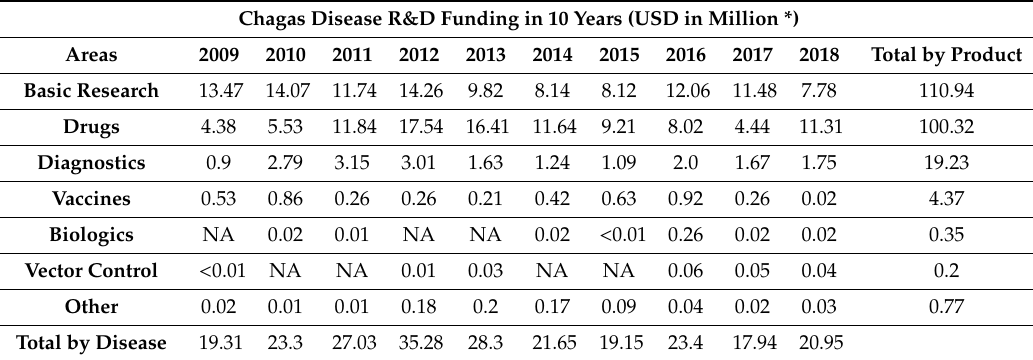
Table 2. Chagas disease R&D funding